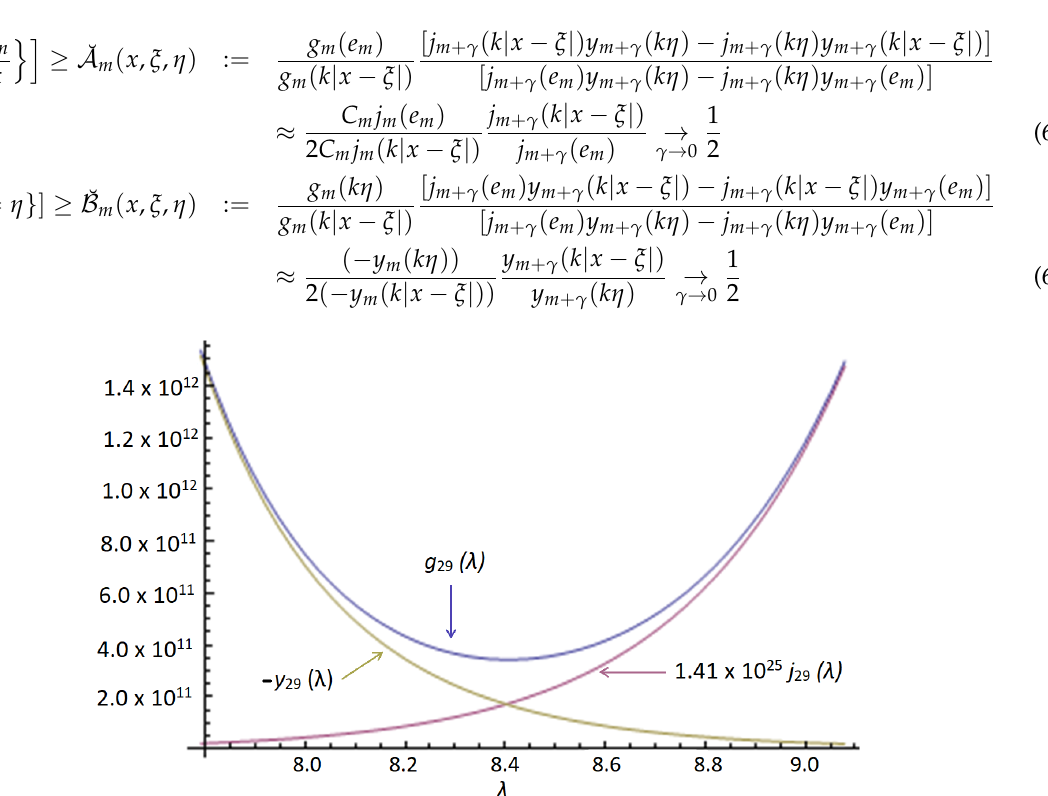
Figure 5. The function g 29 and its constituent terms near the minimum point λ 29